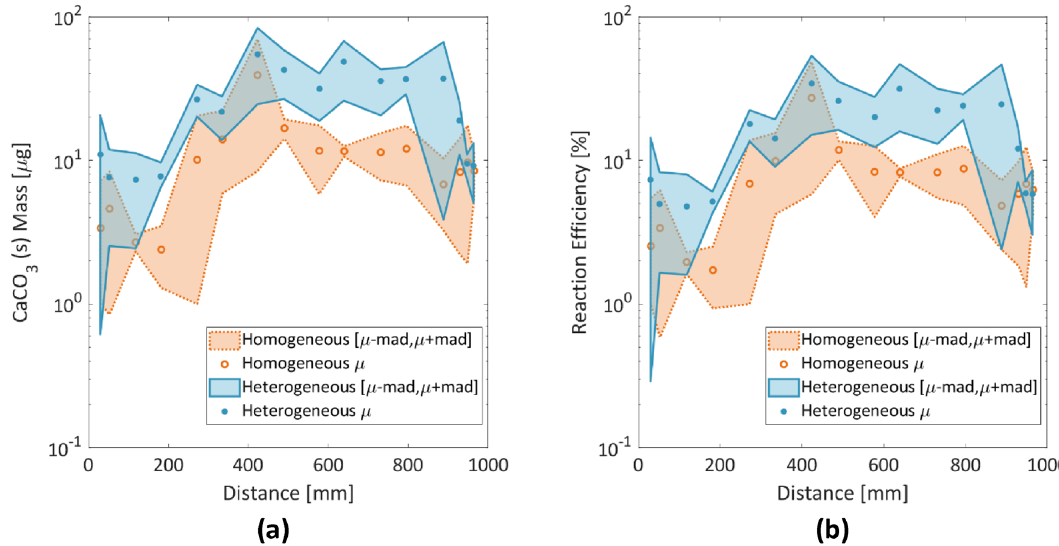
Figure 10. ( a ) Final mass of the precipitated CaCO 3 ; ( b ) estimated reaction efficiency at the end of the MICP treatment (t = 12 h) when crystal growth was completed. Dots represent the averages of the triplicates; shaded areas represent the mean absolute deviation of the triplicates.